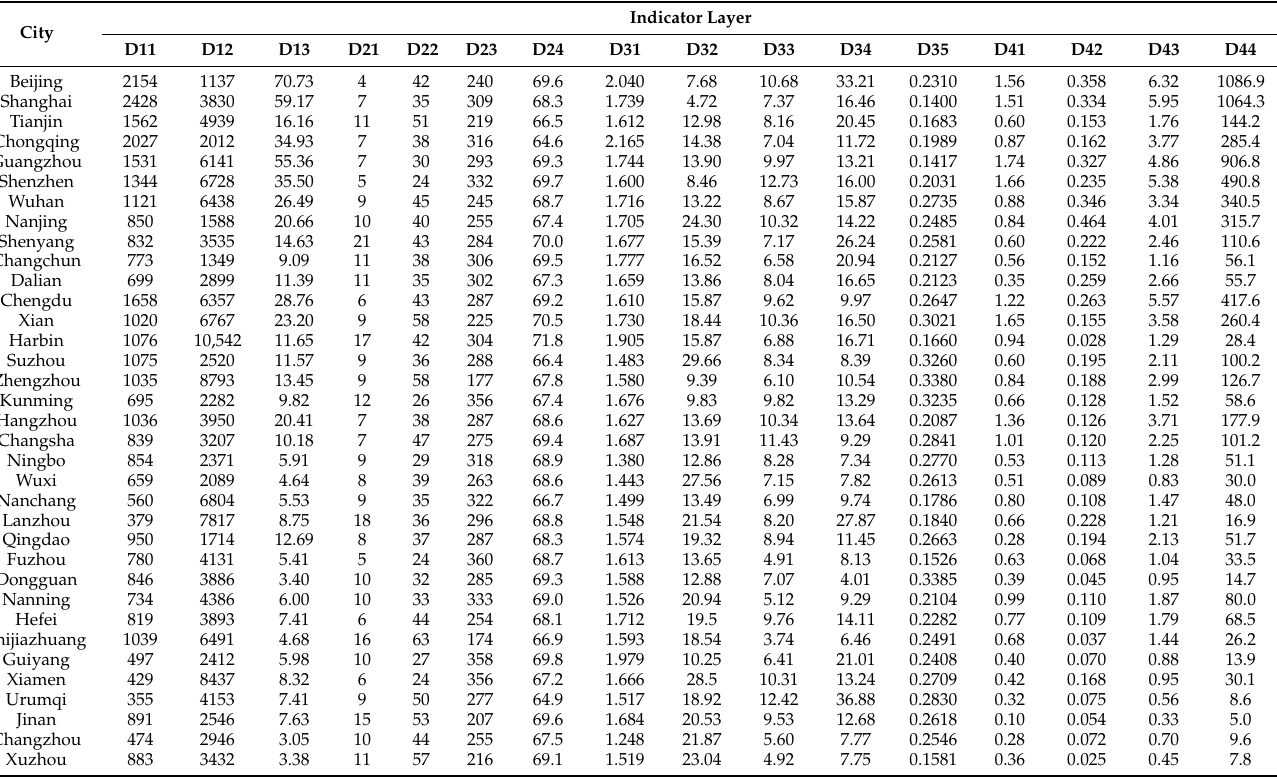
Table A1. Data of Demand